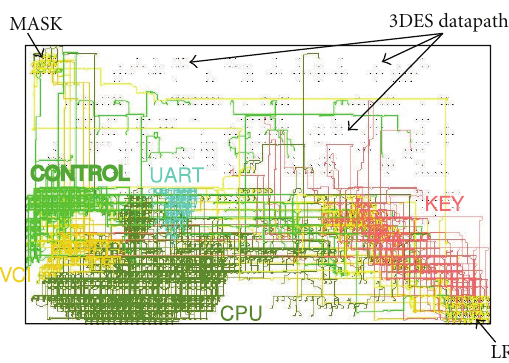
Figure 4: Floorplan of the cryptographic application under ISE floorplanner.